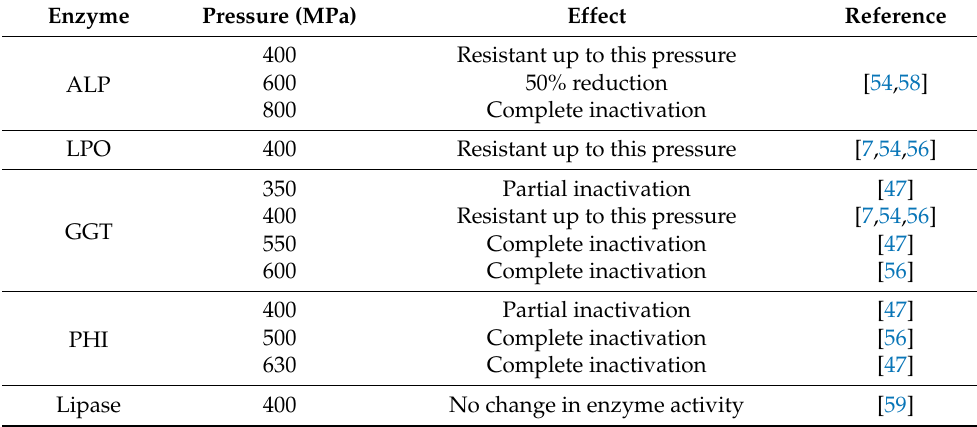
Table 4. Effects of HPP on indigenous milk